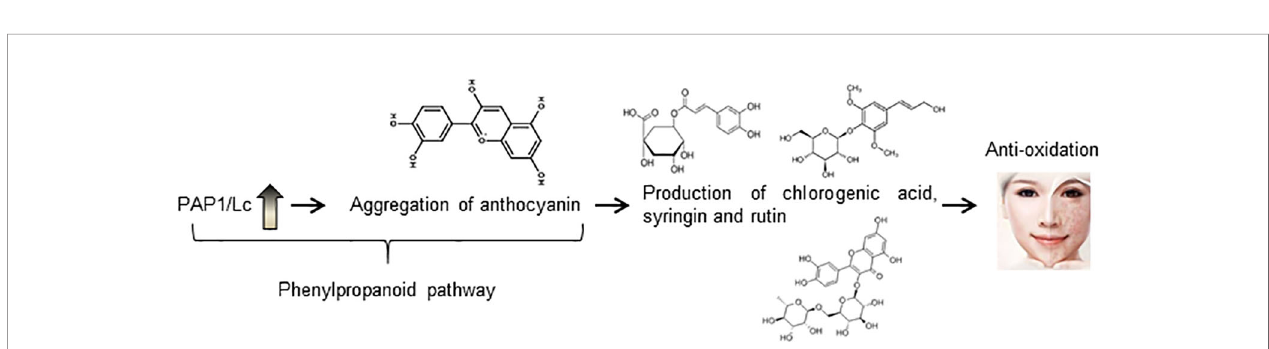
FIGURE 5 | Flow chart of phenylpropanoid pathways. PAP1/Lc up-regulates the biosynthetic pathway of anthocyanin, and which has the mentioned anti-oxidative